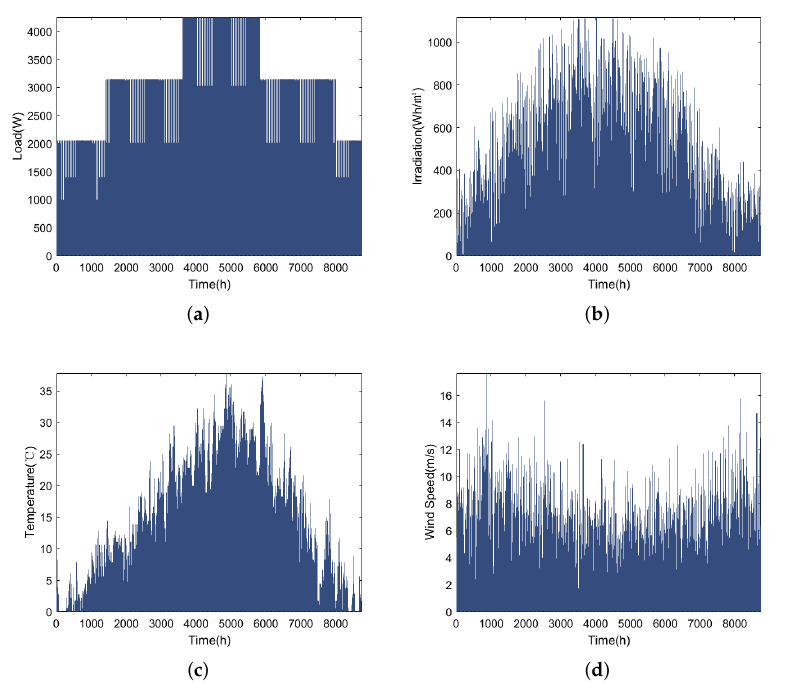
Figure 5. Distribution of load data and environmental data. ( a ) Load. ( b ) Solar irradiation. ( c ) Tem- perature. ( d ) Wind